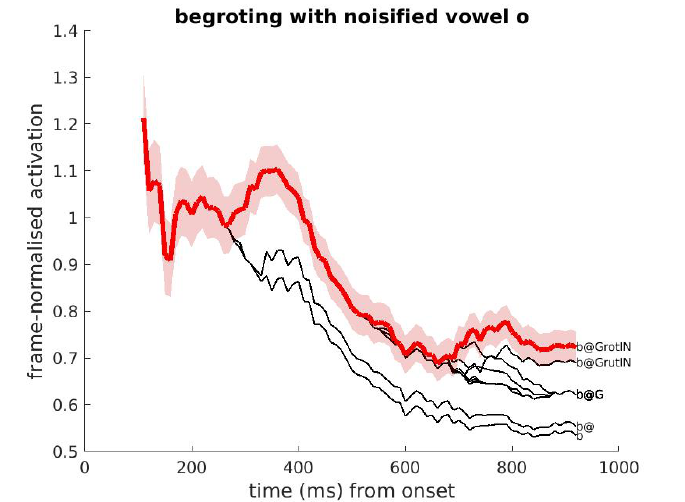
Figure 7. Same as Figure 6, but the noise on the vowel /o/ in the second syllable now yields a reduced and delayed differentiation in the activations of competitors, manifest from 450 ms after onset. Many competitors overlap with each other until stimulus